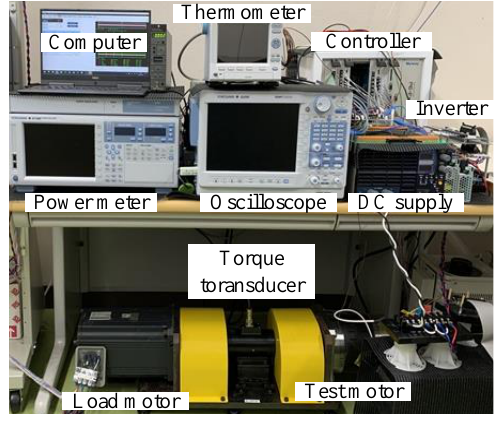
Figure 13. Experimental setup.